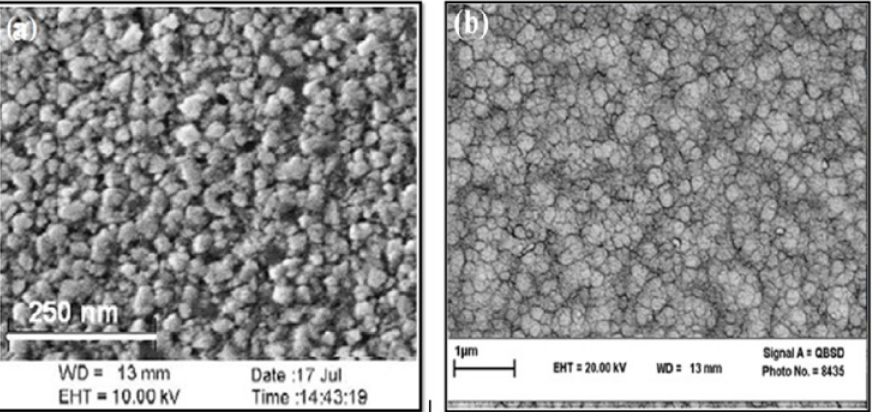
Fig. 2. SEM photographs of a) SnO Fig 2: SEM photographs of a) SnO 2 and b) SnS 2 thin films